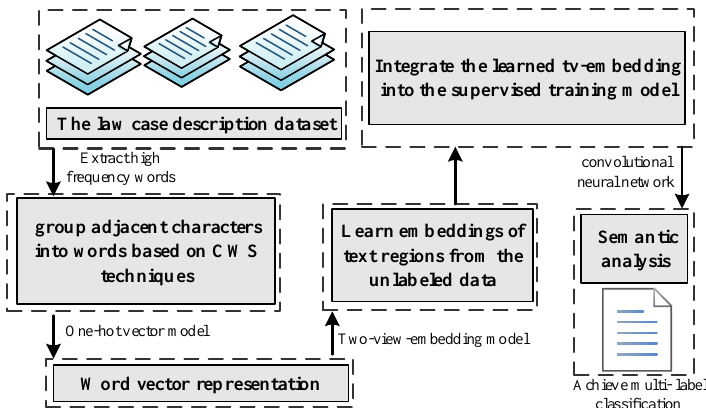
Figure 6. The frame diagram of automatic classification of law text.